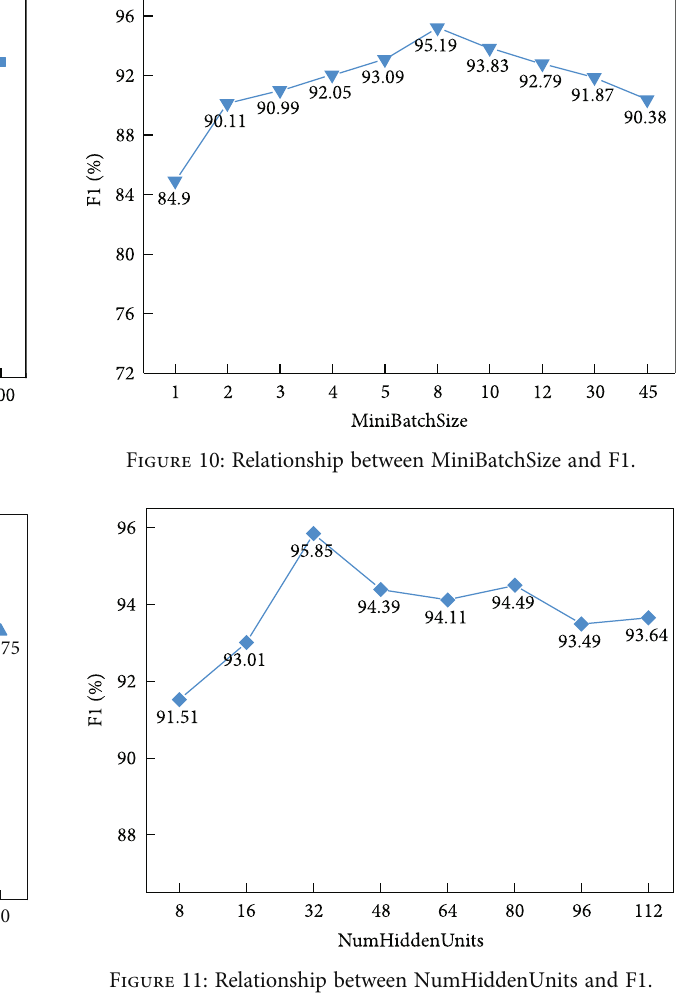
Figure 9: Relationship between learning rate and F1.